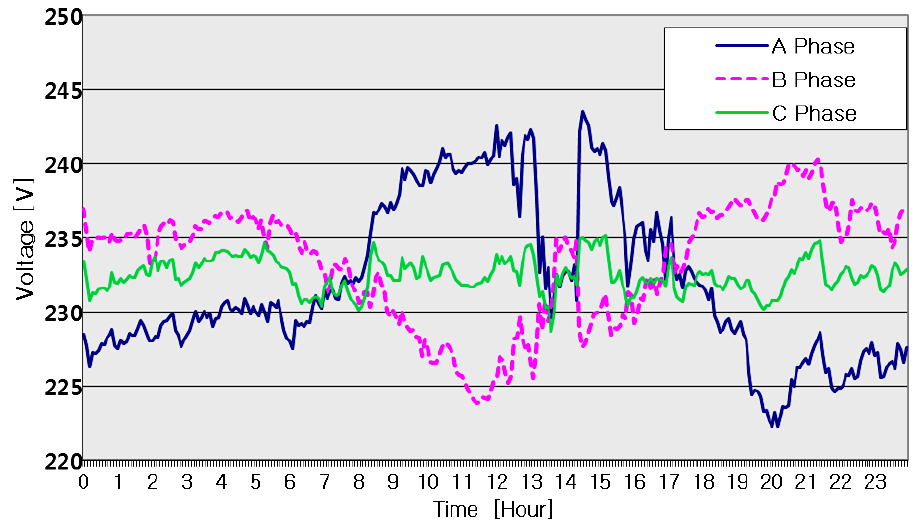
Figure 1. Voltage profile, including photovoltaic (PV) generation, within KEPCO’s low-voltage distribution system during a day (A phase connected with many